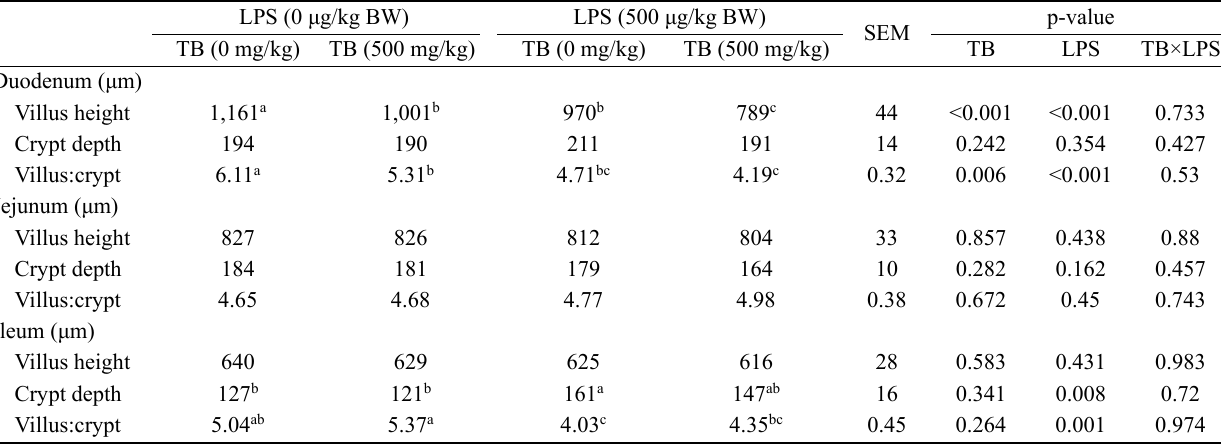
Table 3. Effects of TB on intestinal morphology of broilers challenged with LPS